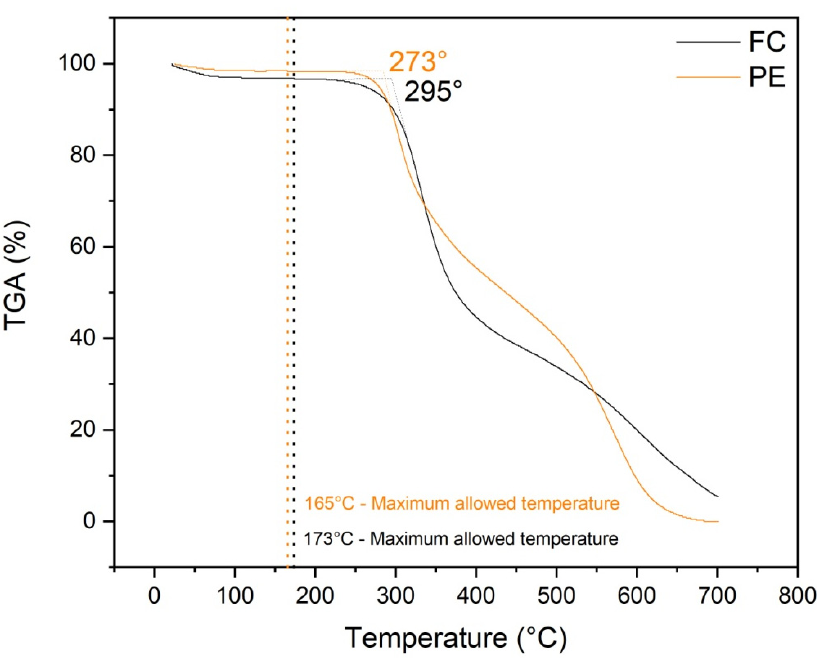
Figure 7. TGA curves of plain epoxy and unaged fique fabric composites. Table 2. DMA parameters obtained for the composite reinforced with 40 vol% fique fabric, aged at high temperature and unaged.